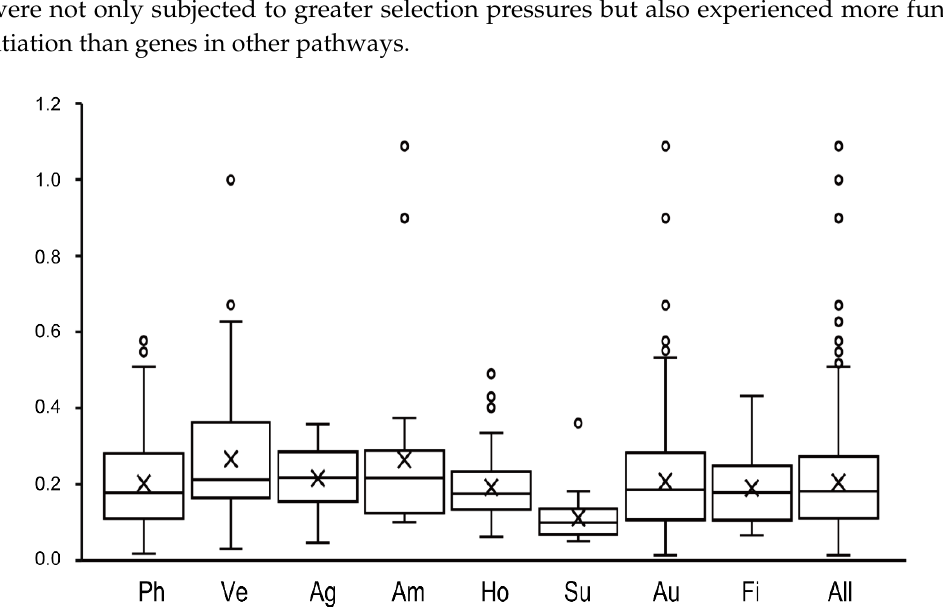
Figure 4. Direction and magnitude of selective pressures acting on different pathways in B. napus . Quantile boxplots show the distribution of Ka/Ks values for orthologous homologous gene pairs. The horizontal bar in each box indicates the median value. The crossbar in each box indicates the average value. The upper and lower bars correspond to the upper and lower adjacent values outside the inter-quartile range. Ph: photoperiodic, lighting, and signaling pathway; Ve: vernalization pathway; Ag: aging pathway, Am: ambient temperature pathway; Ho: hormone pathway; Su: sugar pathway; Au: autonomous pathway; Fi: flowering-time integrator pathway; All: all flowering-time genes identified in our study.